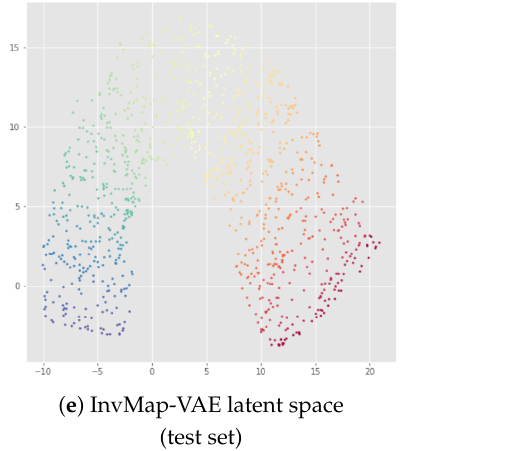
Figure A1. UMAP-based InvMap-VAE applied to the swissroll data set, weight IM = 10 and trained for 1000 epochs. Betti numbers β 0 = 1 and β 1 = 0 are preserved between the original dataset ( a ), the latent representation (( c ) for training and ( e ) for test), and the reconstruction (( d ) for training and ( f ) for test). Latent representations are similar to the UMAP embedding.